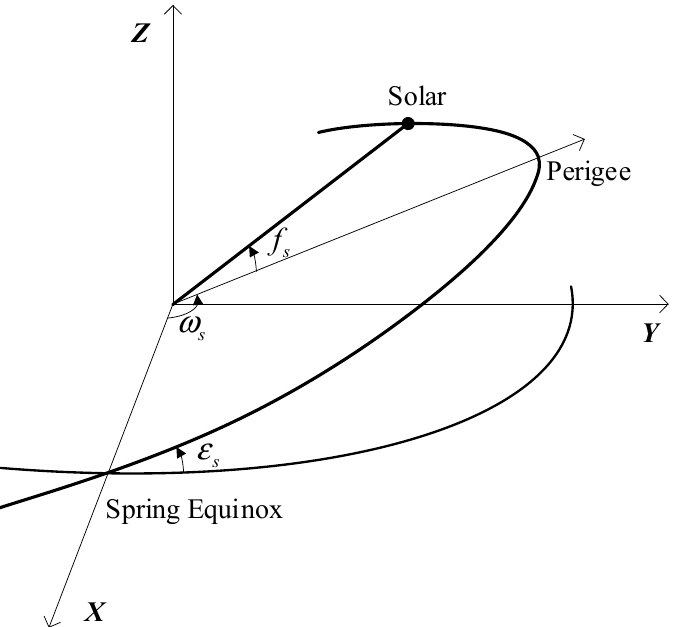
Figure 1. Kepler orbital parameters of the Sun in the celestial coordinate system with the Earth’s equator as the X-Y plane.